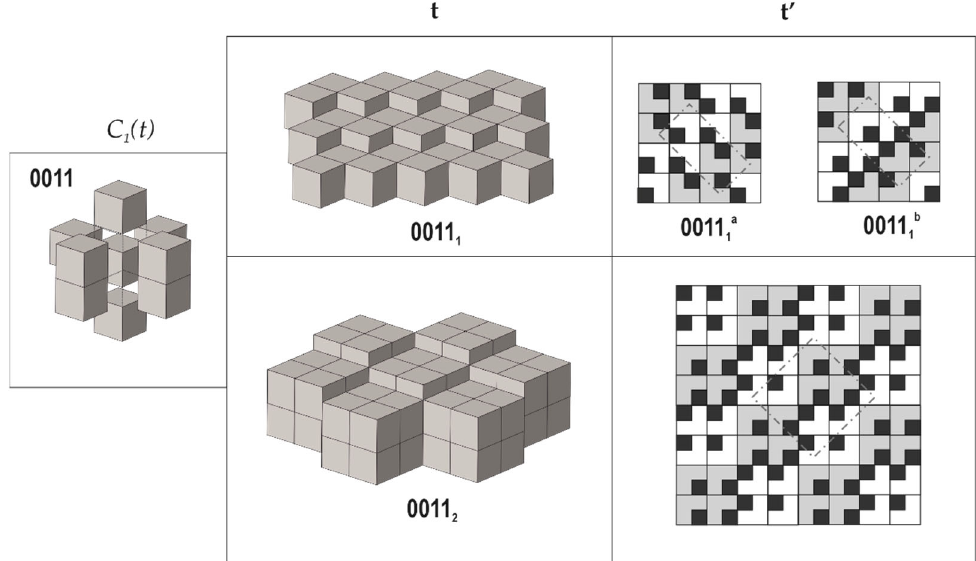
Figure 4. Arrangements of the pseudo ‐ cubic modules in lovozerite ‐ type structures with 0011 local environment. Legend as in Figure 3. Modified after [70].